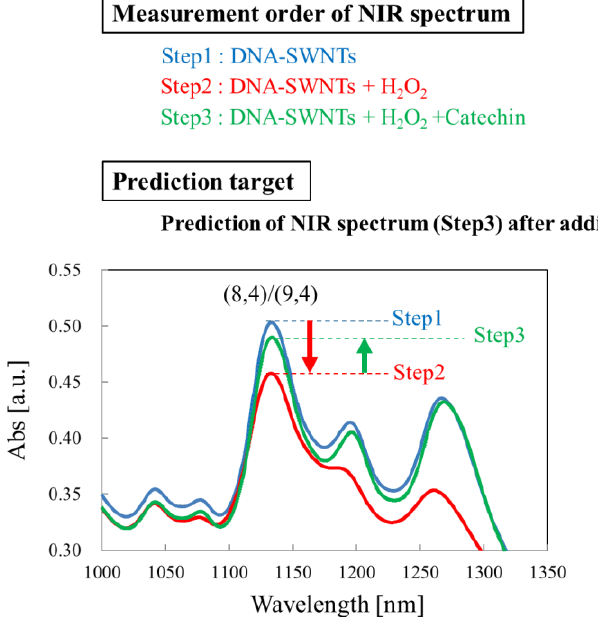
Figure 1. Typical reaction example of experimental data targeted by the BRBPNN model. Blue line of step 1 is NIR spectrum in the initial state of DNA-SWCNTs. Red line is NIR spectrum with H 2 O 2 added to the initial state. Green line is NIR spectrum with catechin added in step 2.